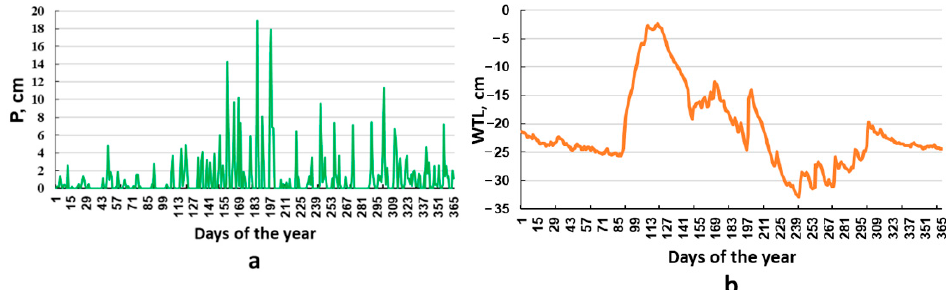
Figure 3. Annual dynamics of daily precipitation (P) according to the meteorological station near Bakchar village ( a ) and groundwater table ( b ) in the study area of GVM in 2019. Bakchar village ( a ) and groundwater table ( b ) in the study area of GVM in